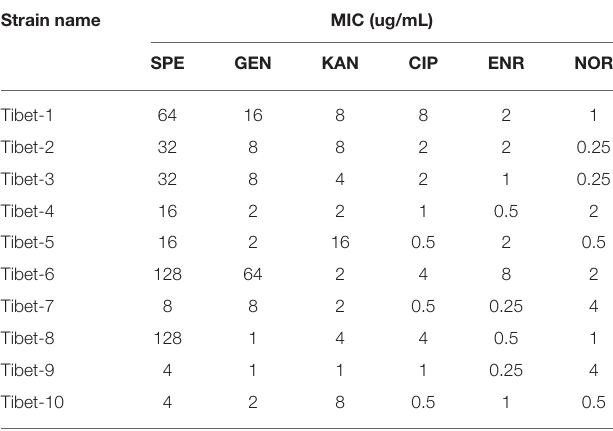
TABLE 2 | The MIC results of the 10 strains